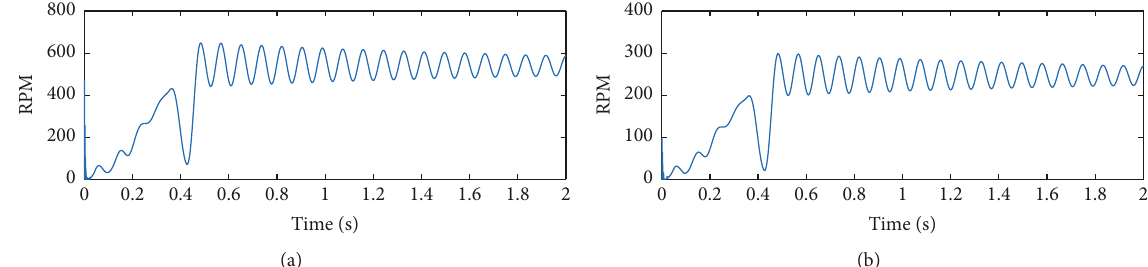
Figure 5: Angular velocities of (a) drive shaft (b) intermediate-stage shaft.